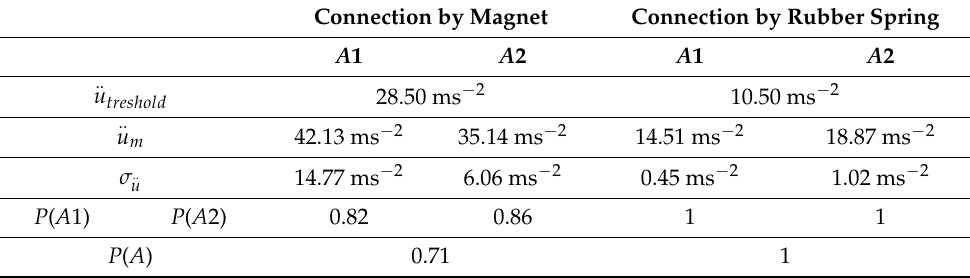
Table 6. Reliability of rolling elements damage